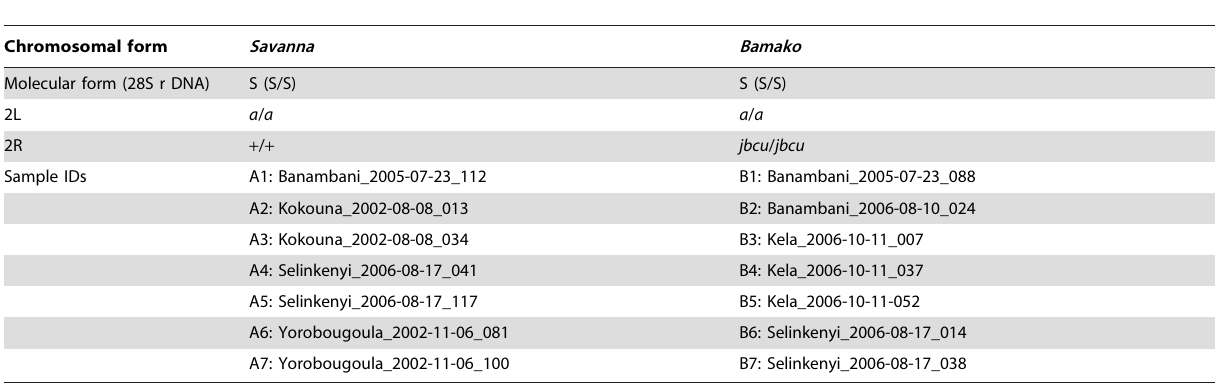
Sample IDs represent a concatenation of collection site, collection date and tube index number, and correspond to identification numbers stored on the publically available online database, PopI at: https://grassi2.ucdavis.edu/. In addition, photomicrographic images of polytene chromosome preparations used to determine karyotypes for all specimens, except the two samples from Yorobougoula, are available on PopI . doi:10.1371/journal.pone.0057887.t001 PLOS ONE |